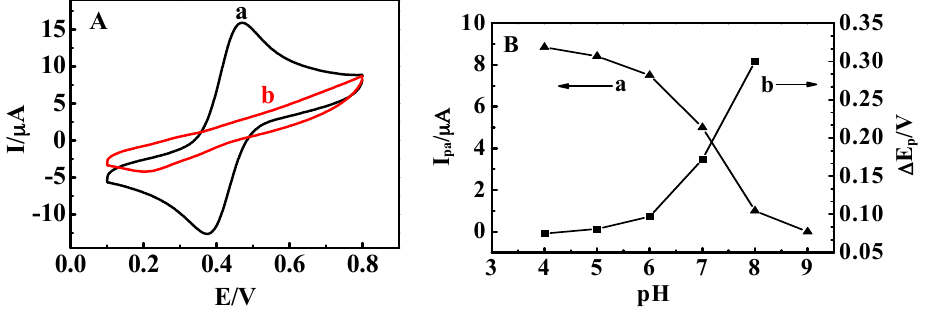
Figure 3. ( A ) CVs of 0.5 mM Fc(COOH) 2 at 0.1 V ¨ s ´ 1 for {Con A/GOD} 5 films in buffers at pH ( a ) 4.0 and ( b ) 8.0; ( B ) Influence of solution pH on ( a ) CV oxidation peak current (I pa ) and ( b ) peak separation ( ∆ E p ) of 0.5 mM Fc(COOH) 2 at 0.1 V ¨ s ´ 1 for {Con A/GOD} 5